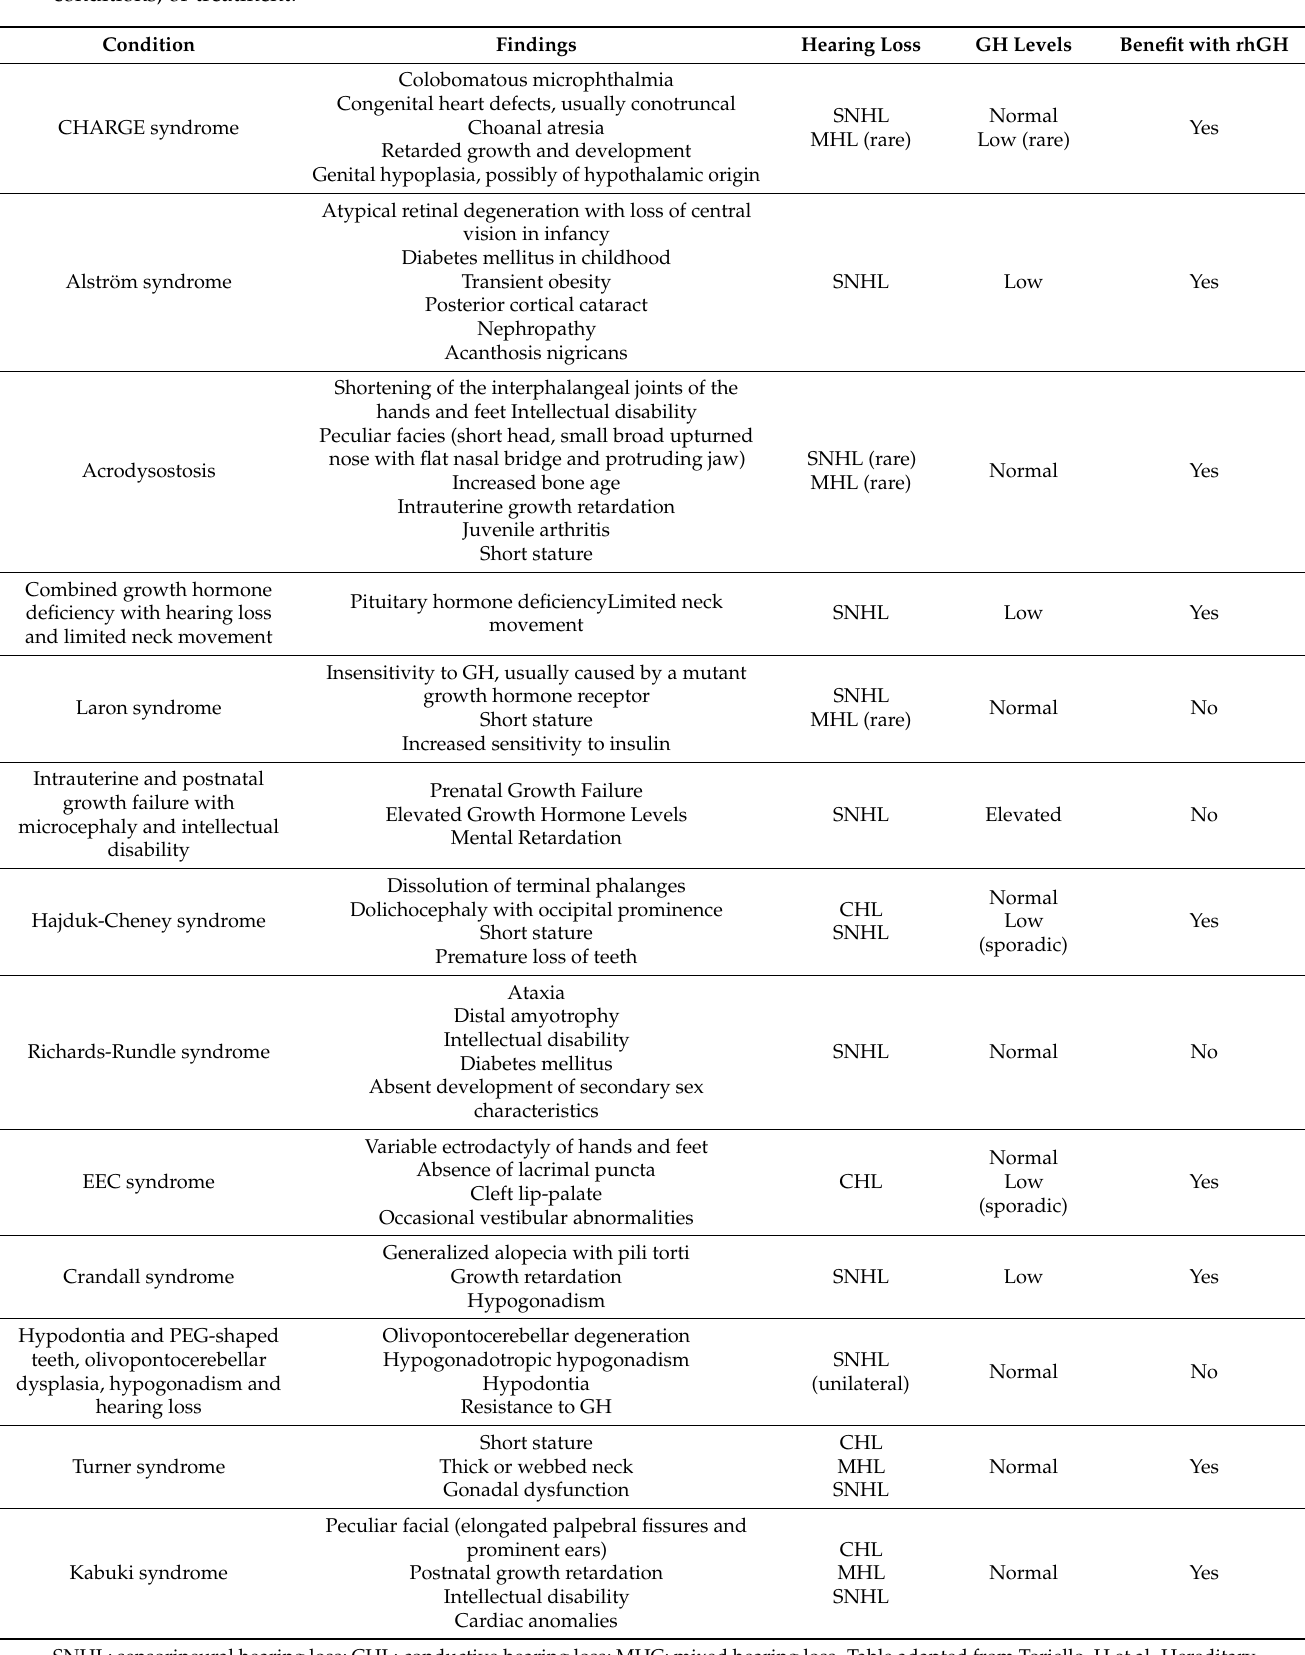
Table 1. Selection of hereditary hearing loss syndromes and the involvement of GH on their pathogenesis, associated conditions, or